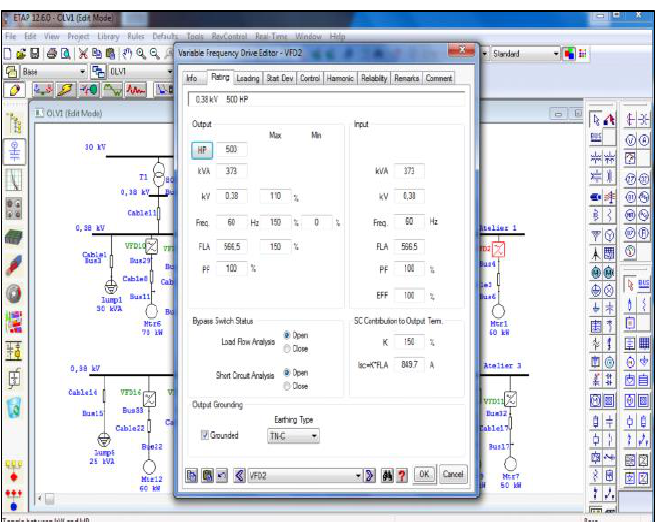
Figure 10: VFD power supply adjustment.